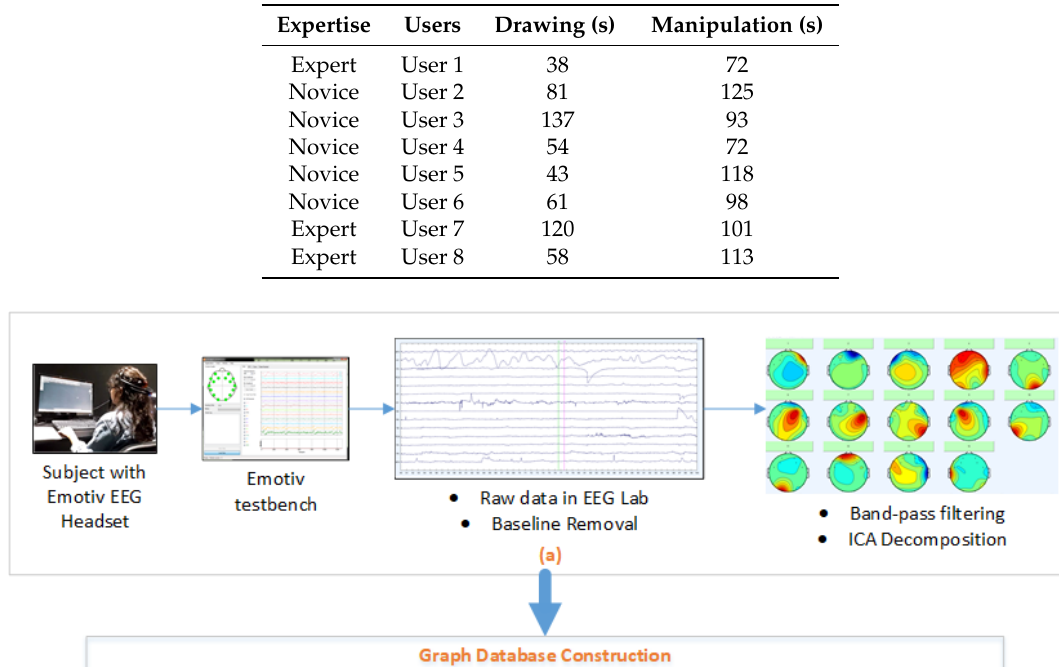
Table 1. Time taken by each participant to complete the task.